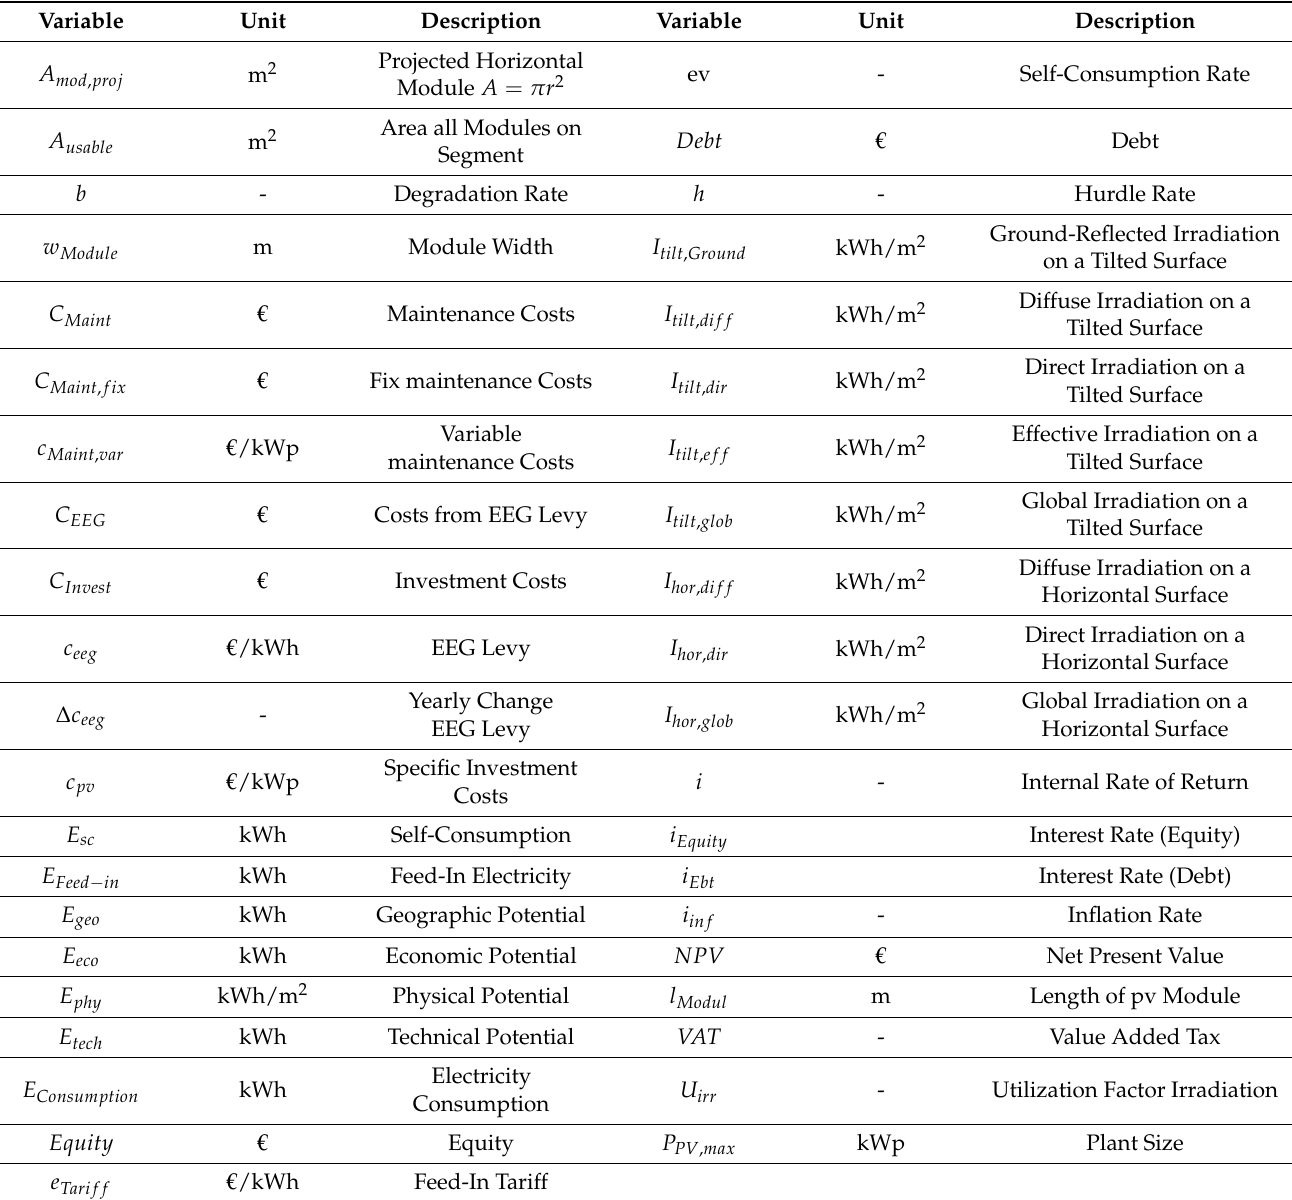
Table A2. Overview of variables used for technical and economic potential calculation.